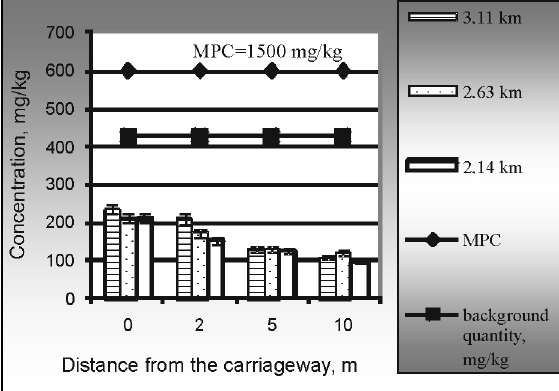
Fig. 13. Manganese concentration in the roadside soil of the gravel road Šeiniūnai – Vindeikiai – Uliškiai As the presented results show, the soil of the gravel road Šeiniūnai – Vindeikiai – Uliškiai is not contami- nated with heavy metals. It is determined that with a dis- tance from the carriageway increasing the concentrations of the heavy metals under review are